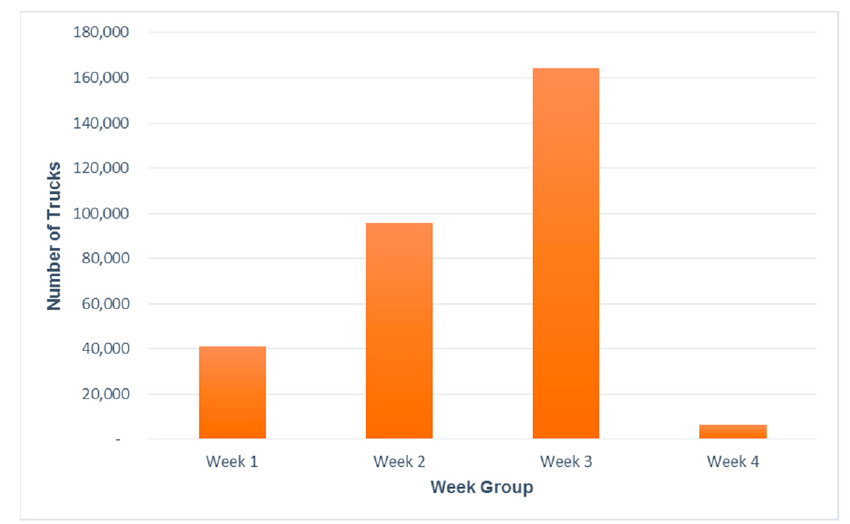
Figure 9. Truck volume during week groups 1–4 after optimization.